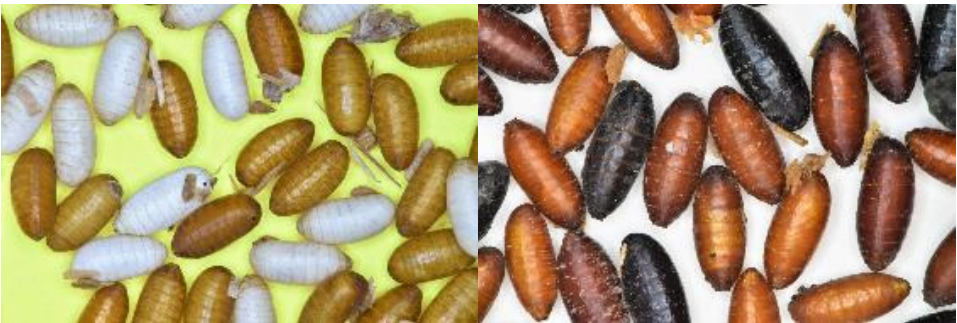
Figure 2. Left: Brown pupae (males) and white pupae (females) from the Ceratitis capitata VIENNA 8 GSS. Right: Brown pupae (males) and black pupae (females) from the Anastrepha ludens Tapachula 7 GSS (Photocredit: C. Caceres).